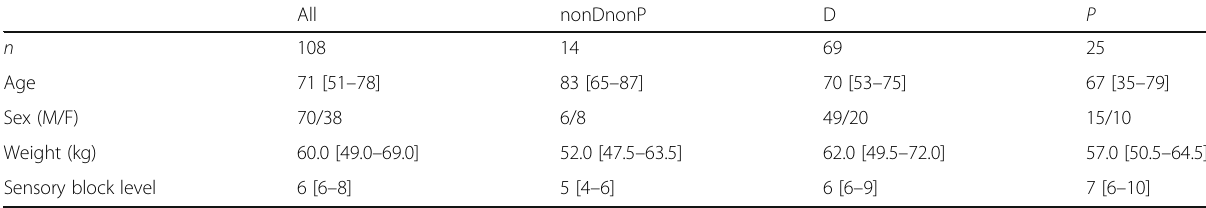
Table 1 Patient characteristics